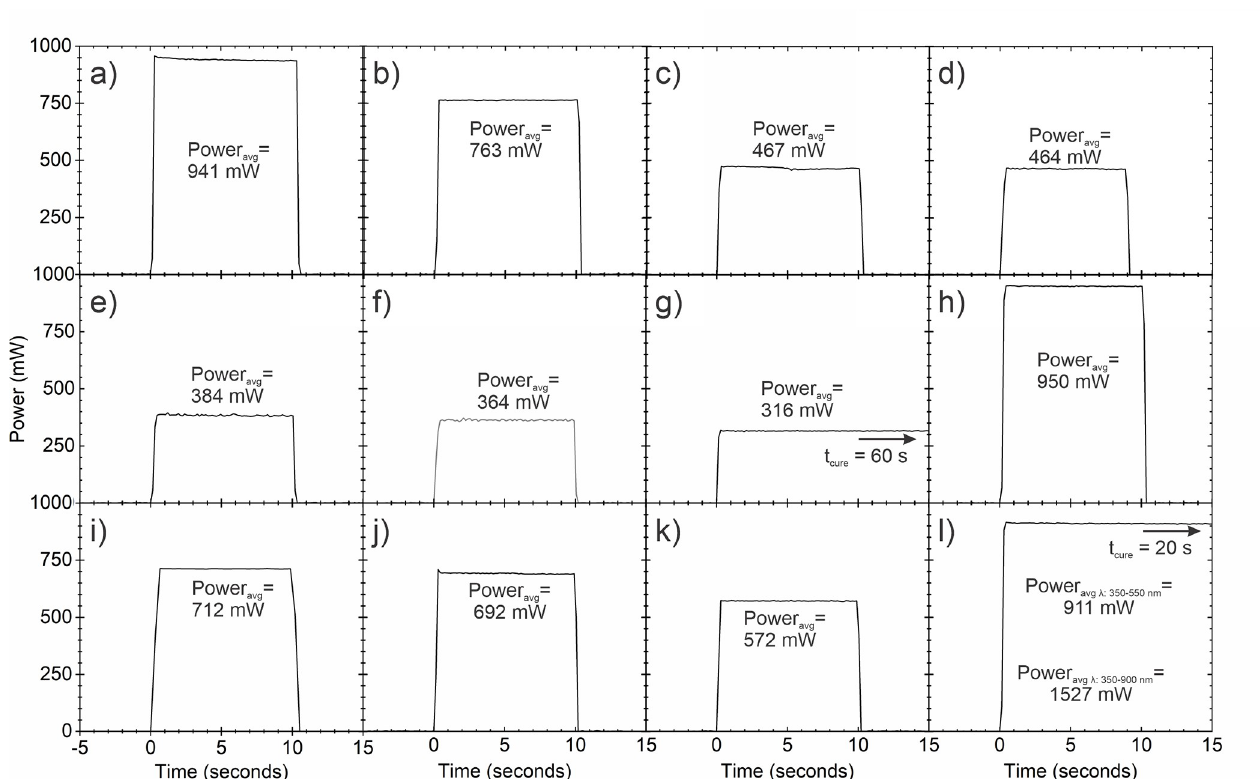
Fig 3. Representative ‘gold standard’ power (mW) emitted by the 12 LCUs evaluated: Single Peak LCUs a) SmartLite Pro; b) DeepCure; c) Dental Spark; d) Denjoy; e) Woodpecker LED D; f) Woodpecker LED B; g) SDI Radii Plus; and Multi-peak LCUs h) Valo Grand; I) Bluephase G4; j) Valo; k) Bluephase Powercure; and l)